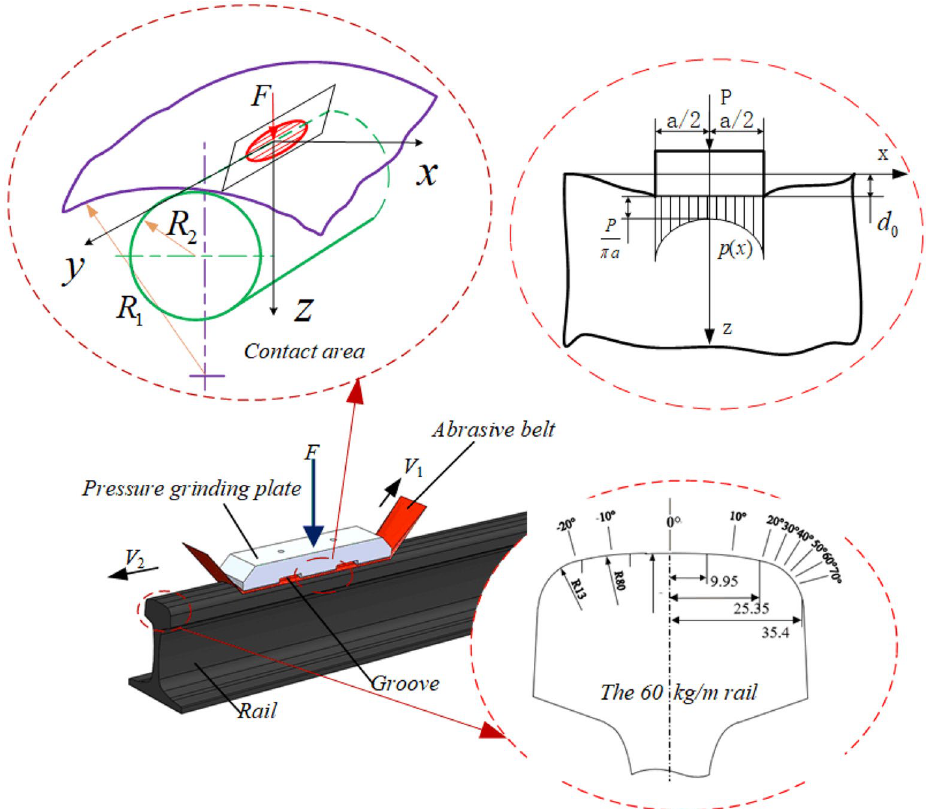
Figure 2 Schematic diagram of press pressing plate—abrasive belt—rail